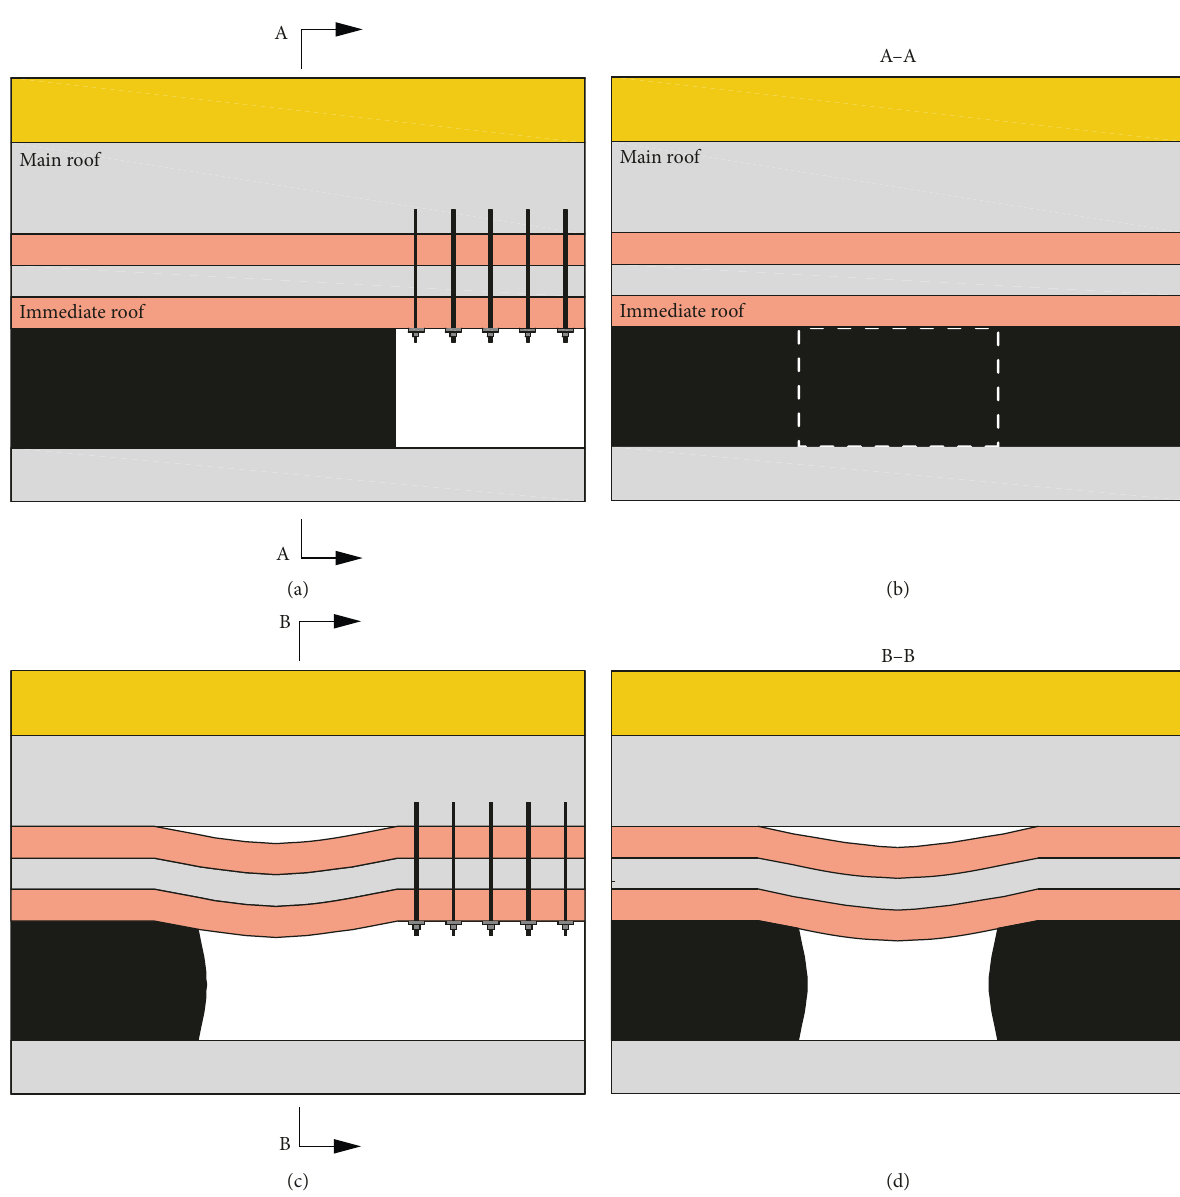
Figure 2: Bearing structure near a typical heading face in coal entry excavation. (a) Front view before the excavation. (b) Cross section before the excavation. (c) Front view after the excavation. (d) Cross section after the